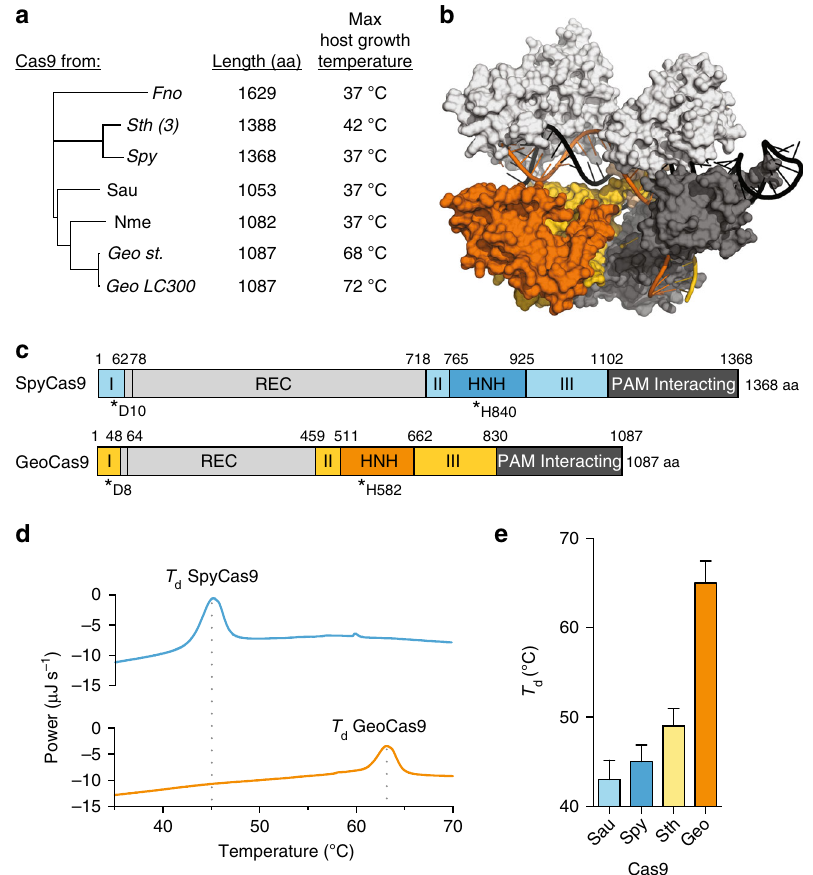
Fig. 1 GeoCas9 is a thermostable Cas9 homolog. a Phylogeny of Cas9 proteins used for genome editing with their length (amino acids) and the maximum temperatures that supports growth of the host indicated to the right 22 . b Homology model of GeoCas9 generated using Phyre 2 47 with the DNA from PDB 5CZZ docked in. c Schematic illustration of the domains of Spy Cas9 (blue) and GeoCas9 (orange) with active site residues indicated below with asterisks. d Representative traces for differential scanning calorimetry (DSC) of GeoCas9 and SpyCas9. e Denaturation temperature of various Cas9 proteins as measured by DSC, mean ± S.D. is shown. Nme Neisseria meningitides , Geo Geobacillus stearothermophilus , Geo LC300 Geobacillus LC300, Spy Streptococcus pyogenes , Sau Streptococcus aureus , Fno Francisella novicida , Sth (3) Streptococcus thermophilus CRISPR III, T d denaturation